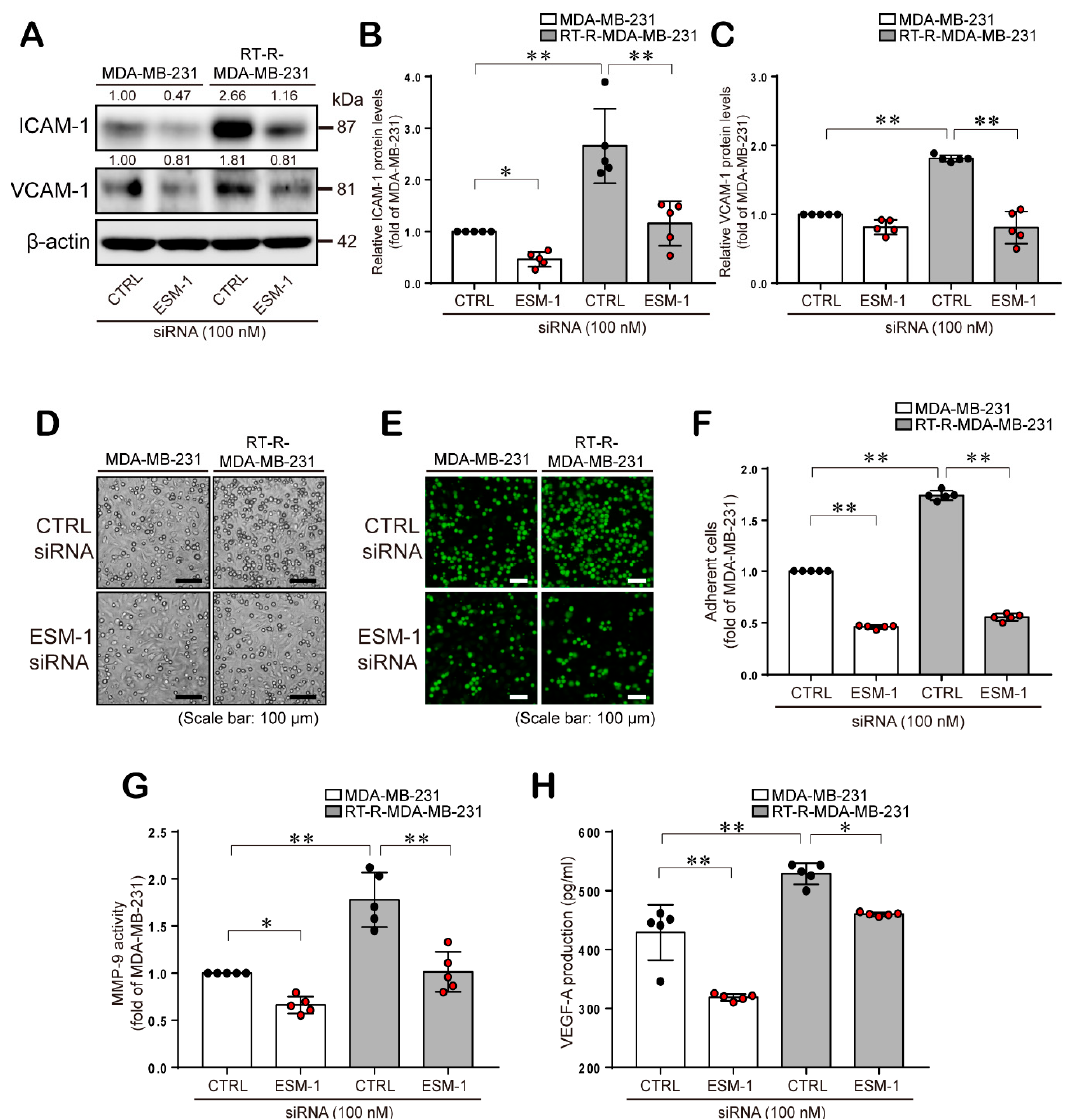
Figure 3. ESM-1 knockdown reduces ICAM-1 and VCAM-1 protein levels, resulting in decreases in the adhesion of cancer cells to ECs, MMP-9 activity, and VEGF-A production in MDA-MB-231 and RT-R-MDA-MB-231 cells. ( A ) ICAM-1 and VCAM-1 protein levels were analyzed in CTRL or ESM-1 siRNA-transfected MDA-MB-231 and RT-R-MDA-MB-231 cells by western blotting. The full blot image can be found in Figure S3. ( B , C ) Relative protein levels of ICAM-1 ( B ) and VC. AM-1 ( C ) were quantified. The data represent the mean ± SD of five independent experiments. ( D – F ) CTRL or ESM-1 siRNA-transfected cells were added to ECs for 30 min, and representative images of the adhesion of cancer cells to ECs are shown using a light microscope ( D ) and a fluorescence microscope ( E ). BC cells that had adhered to ECs were quantified in five randomly selected fields under a fluorescence microscope ( E ). ( G,H ) Cells were transfected with CTRL or ESM-1 siRNA, and MMP-9 activity ( G ) and VEGF-A production ( H ) were detected in conditioned media by zymography and ELISA, respectively. The data represent the mean ± SD of five independent experiments. * p < 0.05, ** p < 0.01. 2.4. ESM-1-Overexpressing RT-R-MDA-MB-231 Cells Increase ERK1/2, PKC, and PDK1 Activation and then Transcription Factor Hypoxia-Inducible Factor-1 α (HIF-1 α ) Induction and NF- κ B and STAT-3 Activation